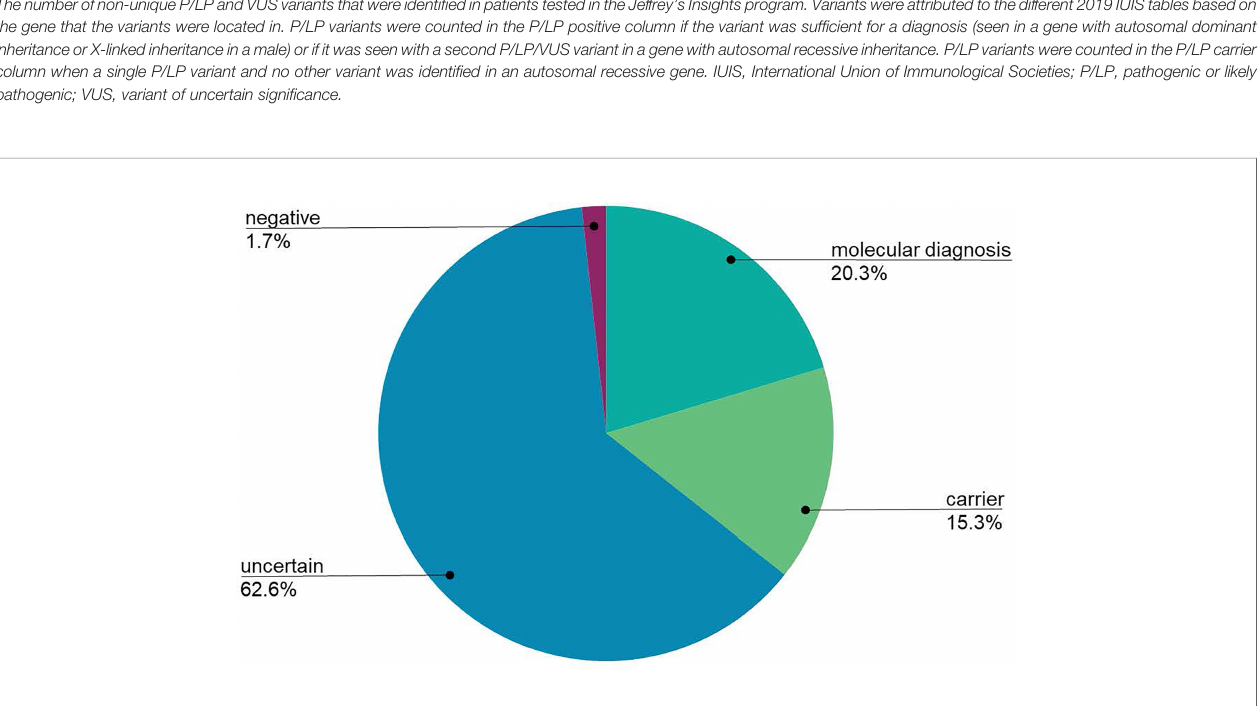
FIGURE 2 | The global diagnostic yield of the Jeffrey ’ s Insights Program. To determine the overall diagnostic yield, individuals that received a con fi rmed molecular diagnosis or likely molecular diagnosis were grouped together (labeled molecular diagnosis in the fi gure). Individuals with 1 P/LP and 1 VUS in an autosomal recessive gene were considered to have a likely diagnosis. Uncertain results were patients who only received variants of uncertain signi fi cance. Individuals who did not have any pathogenic, likely pathogenic, or variants of uncertain signi fi cance identi fi ed were grouped in the negative results. Individuals who were tested for an indication of common variable immunode fi ciency (CVID) were excluded from this calculation due to the primarily multifactorial nature of this